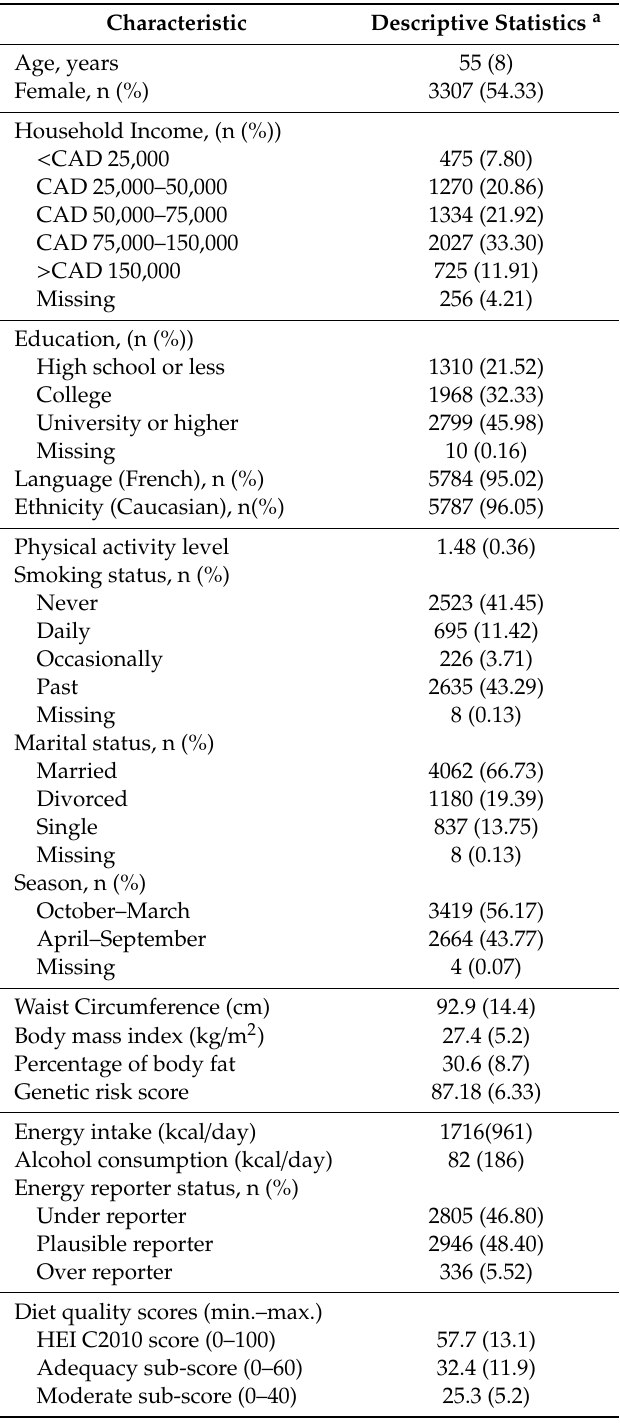
Table 1. Participant characteristics ( n =